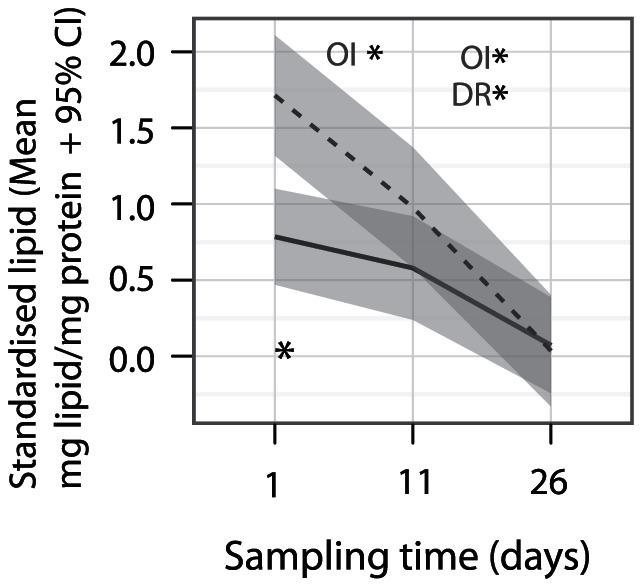
Variation in standardised lipid content of corals among sampling times and source populations.Lines represent mean standardized lipid content (mg lipid per g coral/mg protein per g coral) among replicate colonies (solid line = Davies Reef, dashed line = Orpheus Island). Grey-shaded areas represent the 95% confidence intervals of means. Population specific model-derived significant differences between consecutive sampling times are indicated above the plots (FDR adj. P
MCMC<0.018) and differences between populations below the plots (FDR adj. P
MCMC<0.024).